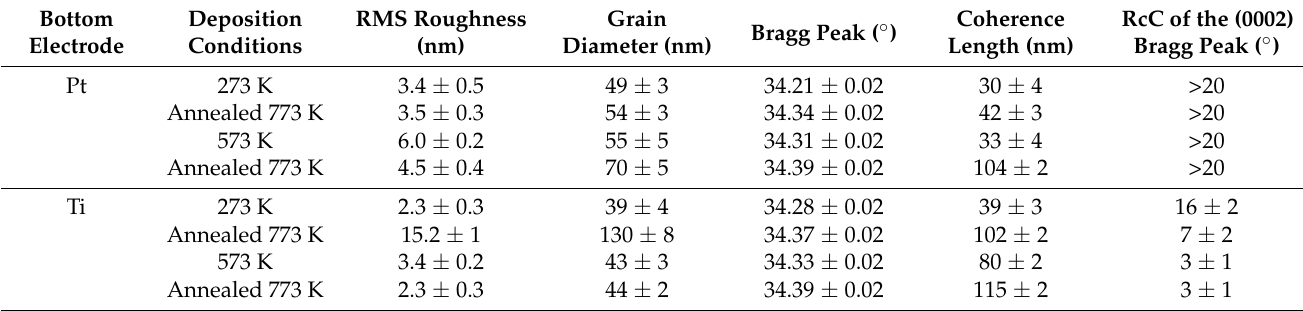
Table 1. Measured experimental parameters of ZnO films on two different electrodes, Pt and Ti, deposited in 75% O 2 at RT and 573 K, and then annealed at 773 K in 50% O 2 and 50% N 2 atmosphere. Bottom